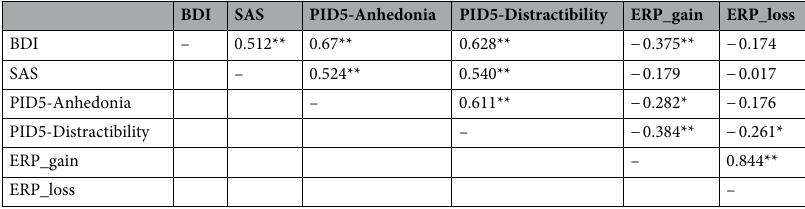
Table 2. Bivariate correlations between the self-reported data and ERPs. BDI Beck Depression Inventory, SAS Self-Rating Anxiety Scale, PID5 DSM-5 personality inventory, ERP_gain gain-feedback-locked ERP component, ERP_loss loss-feedback-locked ERP component, ΔRewP reward positivity. * p < 0.05; ** p < 0.01 (correction for multiple comparisons based on